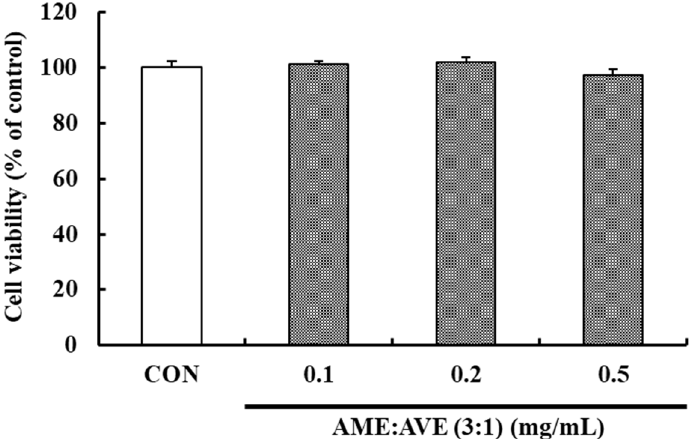
Figure 1. Cytotoxic effects of the mixture of Atractylodes macrocephala and Amomum villosum extracts (3:1) in 3T3-L1 preadipocytes. No significant difference was found in viability compared